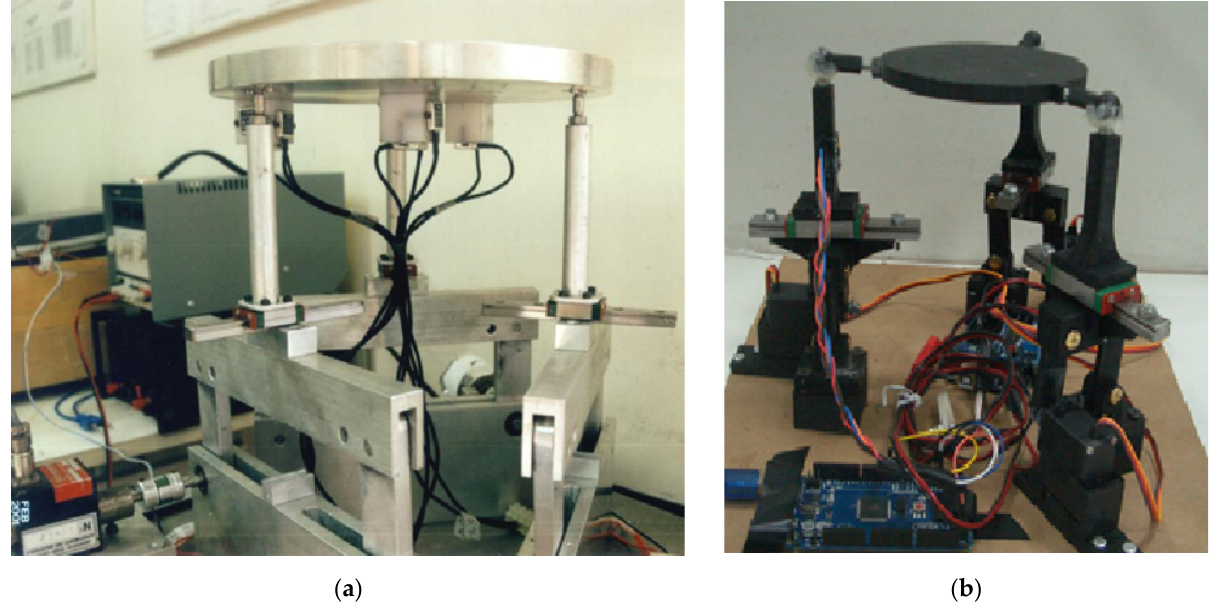
Figure 1. CaPaMan prototypes: ( a ) original design from 1997 [13]; ( b ) 3D-printed solution from 2017 [21]